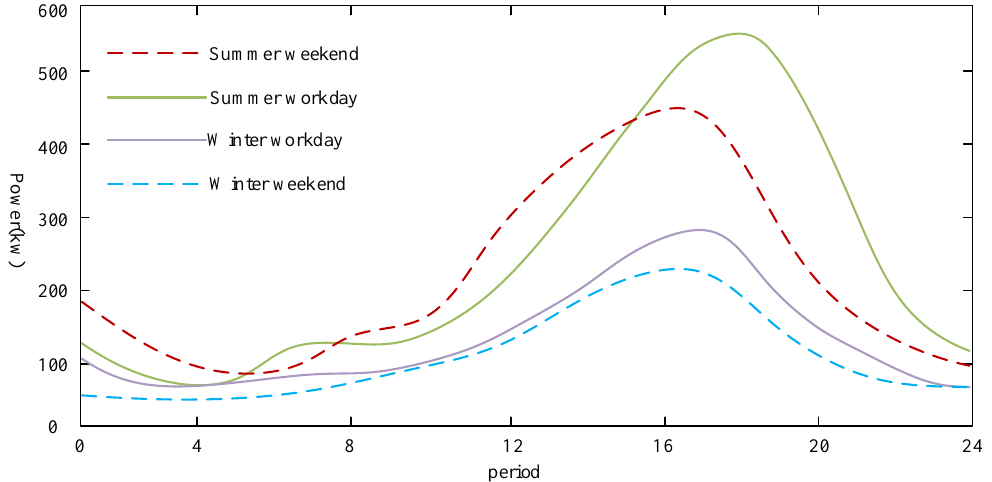
Figure 7. Prediction of charging demand for electric vehicles in different scenarios.